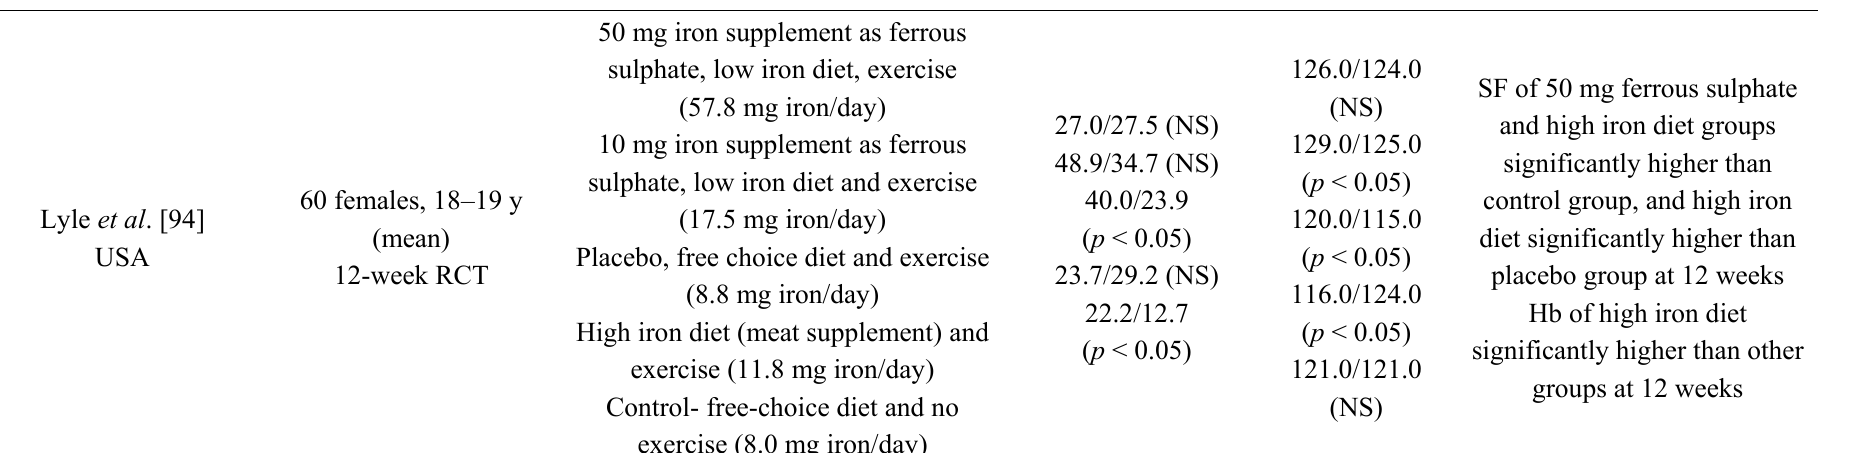
Table adapted from “Iron and Health” Scientific Advisory Committee on Nutrition [20]; a : Mean serum ferritin and hemoglobin following 8-weeks consumption of vegetarian and omnivore diet. Abbreviations: Hb—Hemoglobin; n/a—not available; NS—non significant; RCT—Randomized controlled trial; SF—Serum ferritin; sTfR—Soluble transferrin